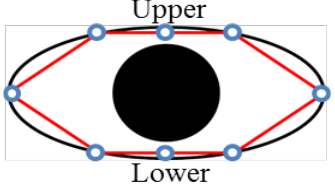
Figure 3. The geometric model for the eye.